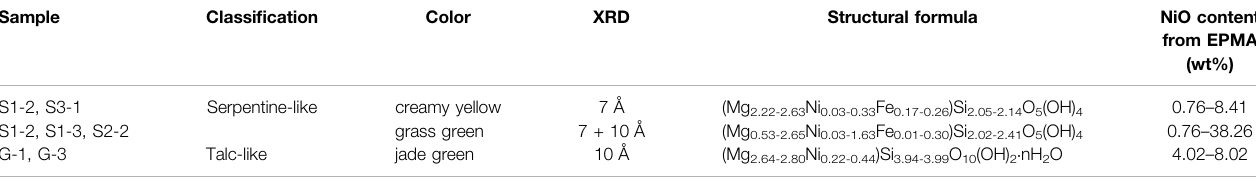
TABLE 1 | Summary of the garnierite characteristics from this study.